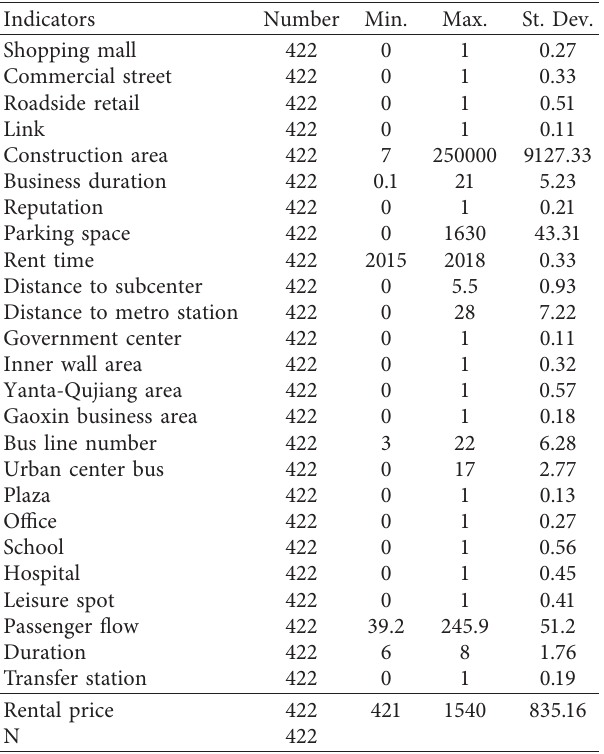
Table 4: Statistical results of the commercial property samples along Xi’an’s ML #1 and ML #2. Indicators Number